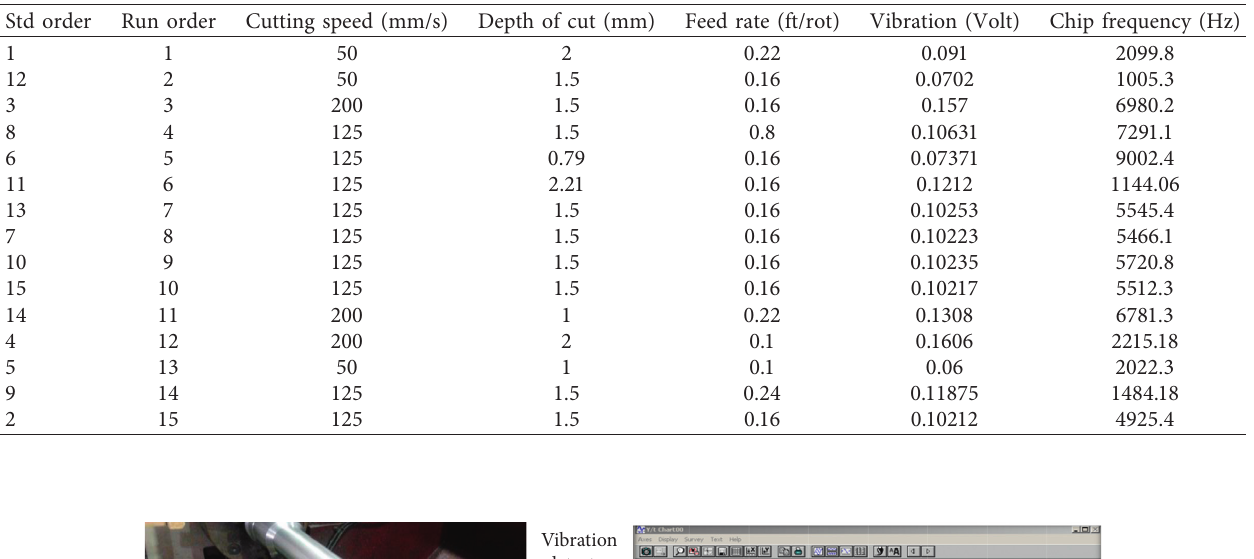
Table 2: Design of the experiments and results of vibration and chip frequency.